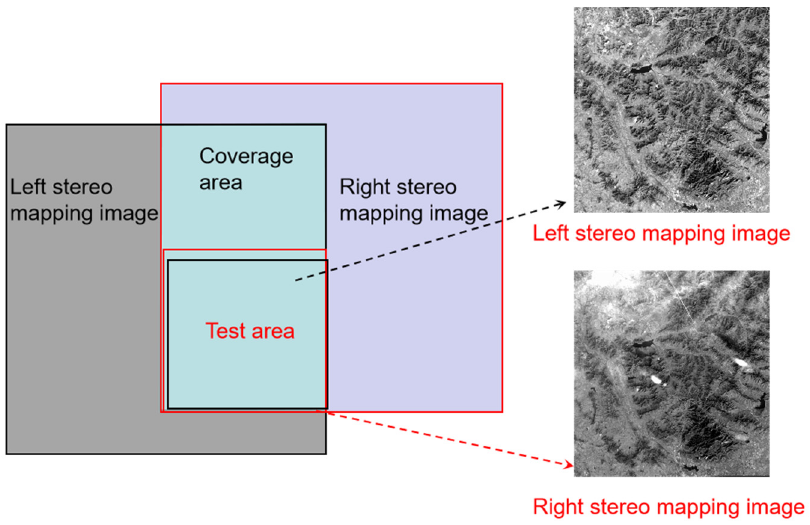
Figure 4. The coverage of the experimental image.